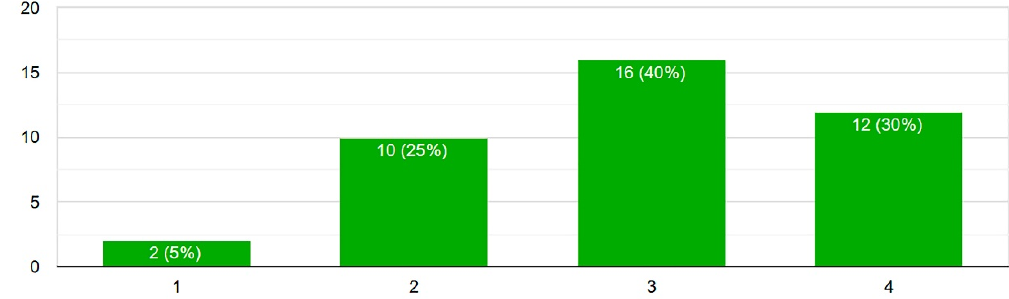
Figure 16. Results about connection between math and sustainability.